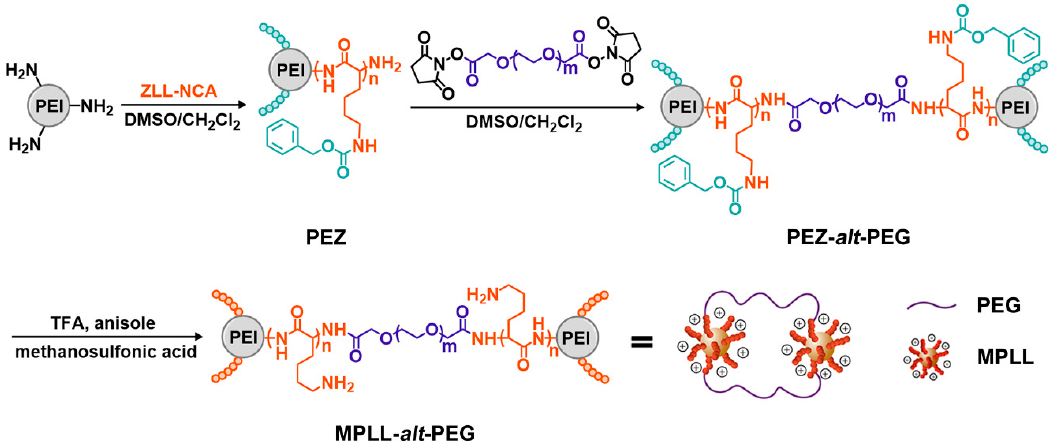
Figure 1. The synthesis route of MPLL- alt -PEG copolymers. PEI: polyethylenimine; PEZ: PEI-grafted poly( ε -benzyloxycarbonyl- L -lysine); TFA: trifluoroacetic acid.